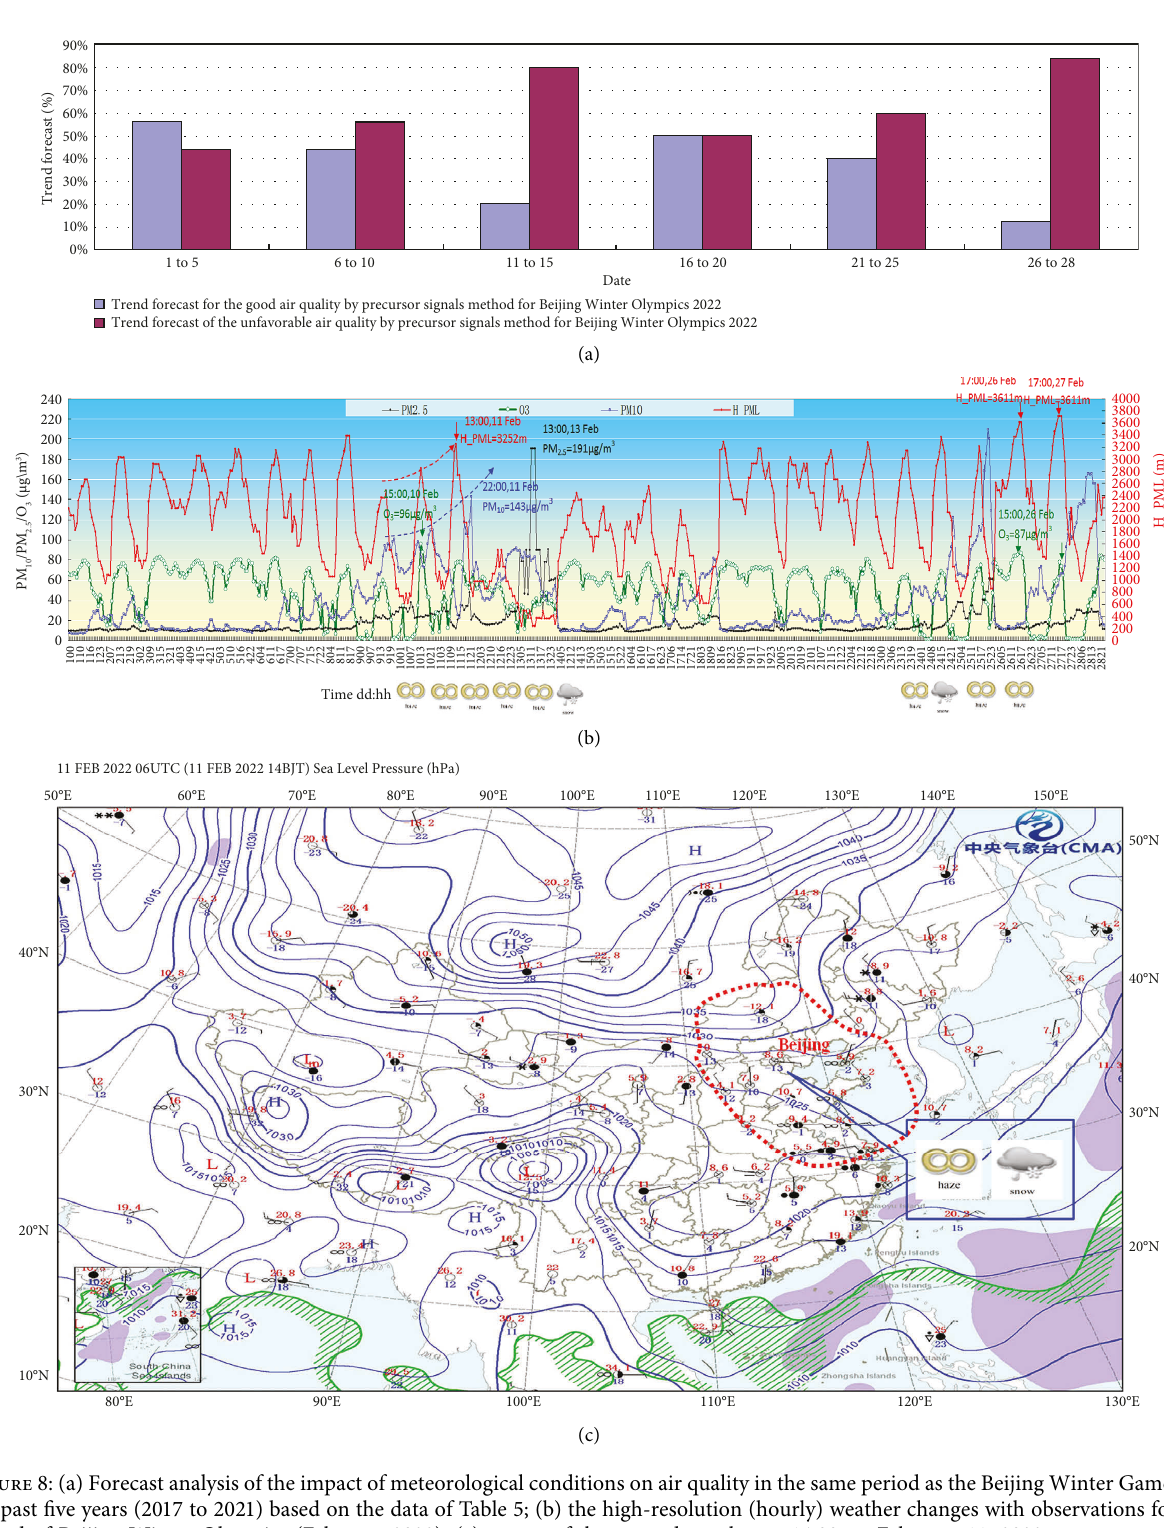
Figure 8: (a) Forecast analysis of the impact of meteorological conditions on air quality in the same period as the Beijing Winter Games for the past five years (2017 to 2021) based on the data of Table 5; (b) the high-resolution (hourly) weather changes with observations for the period of Beijing Winter Olympics (February 2022); (c) a map of the ground weather at 14:00 on February 11,